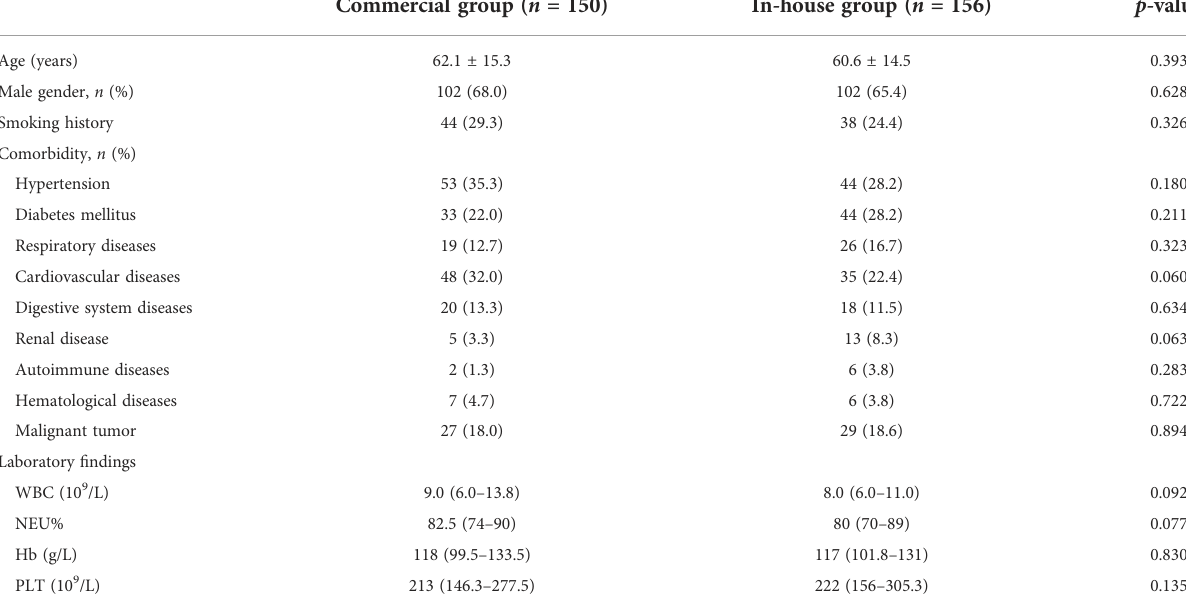
TABLE 1 Clinical characteristics and laboratory fi ndings of